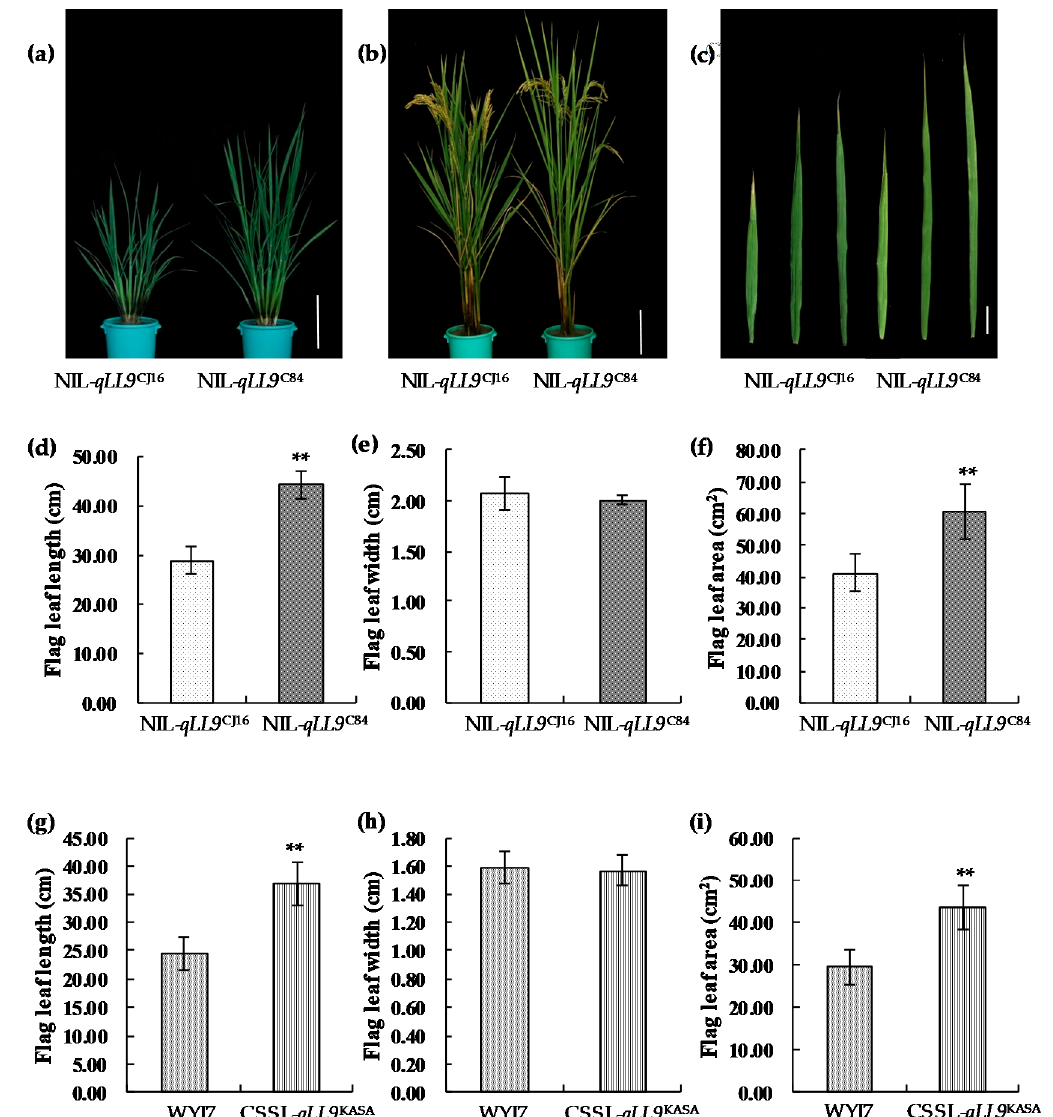
Figure 5. Phenotypes of near-isogenic lines and chromosome segment substitution lines. ( a ) Plant morphology at tillering stage; bar = 18 cm. ( b ) Plant morphology at heading stage; bar = 18 cm. ( c ) The top three leaf shape of NIL- qLL9 CJ16 and NIL- qLL9 C84 . From left to right are the first leaf, the second leaf, and the third leaf, respectively; bar = 5 cm. Comparison between the NIL- qLL9 CJ16 and NIL- qLL9 C84 for the flag leaf length ( d ), the flag leaf width ( e ), and the flag leaf area ( f ). Comparison between Wuyunjing (WYJ) 7 and chromosome segment substitution line (CSSL)- qLL9 KASA for the flag leaf length ( g ), the flag leaf width ( h ), and the flag leaf area ( i ). Data are mean ± SD ( n = 15). Asterisks represent significant difference determined by Student’s t- test at p -value < 0.01 (**).